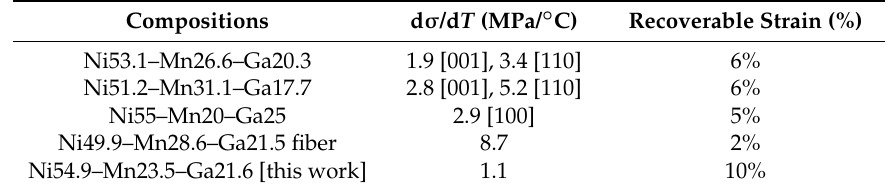
Figure 6. The critical SIM formation stress vs. temperature in the Ni54.9–Mn23.5–Ga21.6 fiber. Table 1. The stress–temperature slope, d σ /d T , and recoverable strain of Ni–Mn–Ga single crystalline and fibers made by melt extraction.